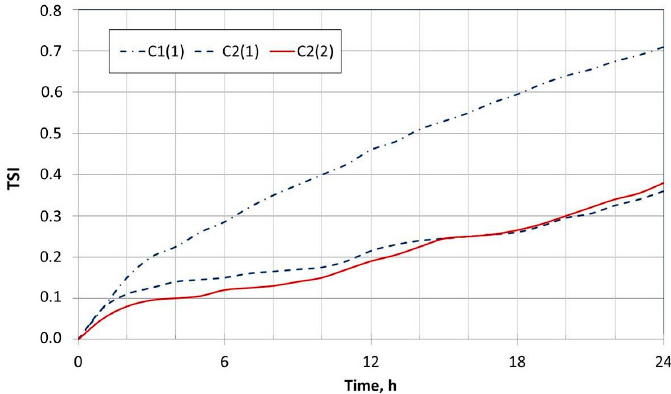
Figure 10. Comparison of the time evolution of TSI as a function of the composition and modality of preparation.